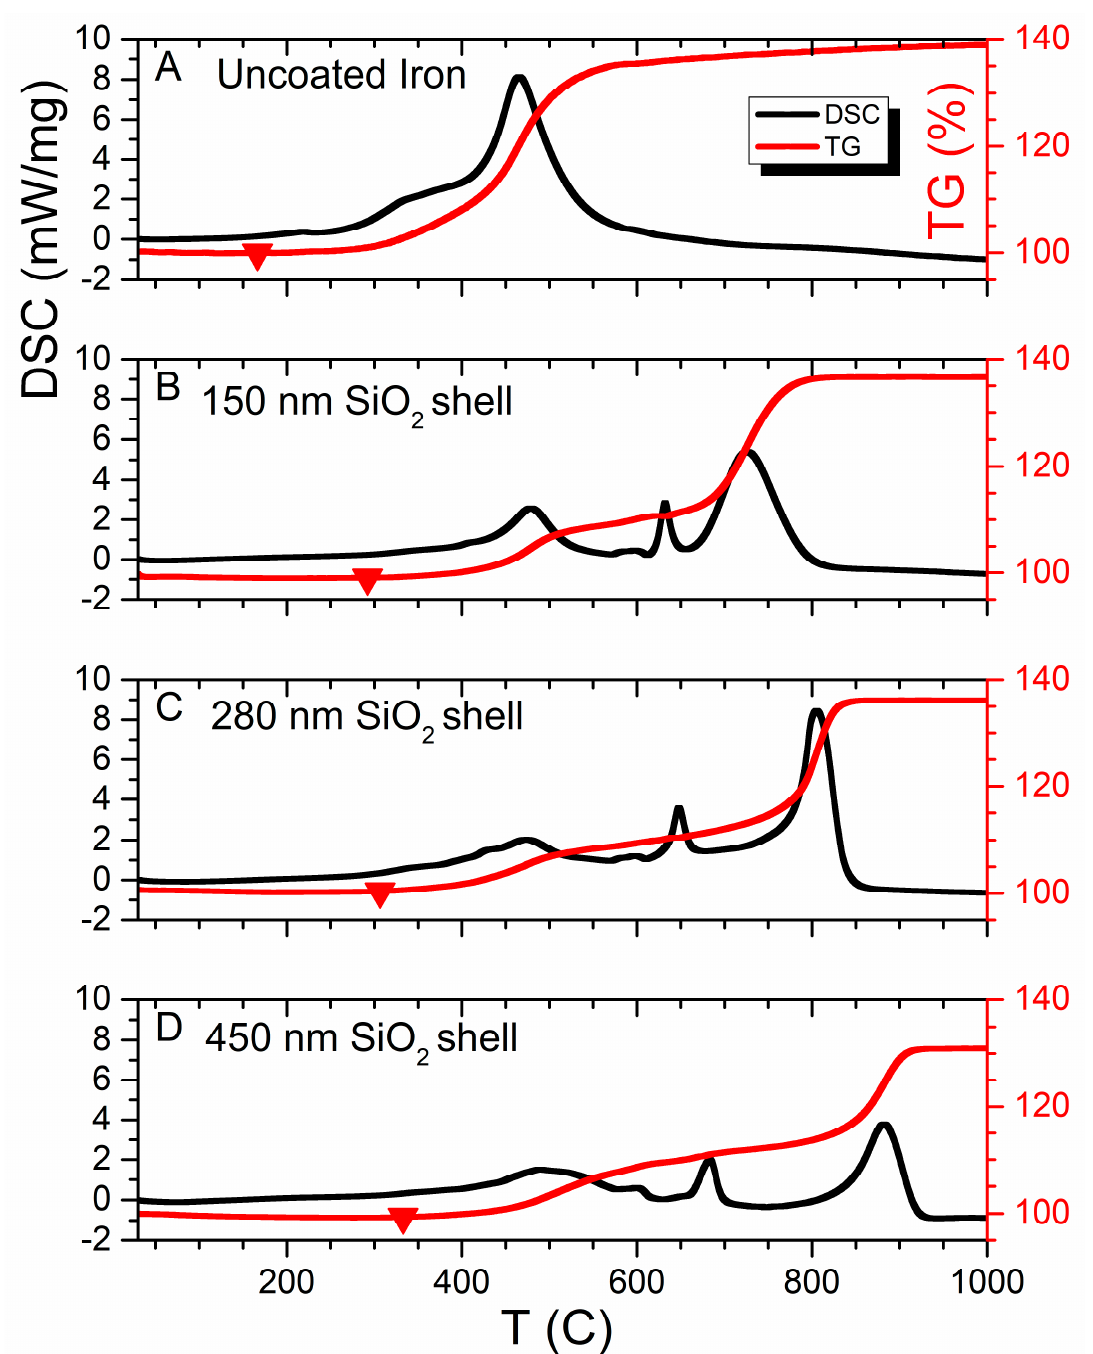
Figure 10. Synchronous thermal analysis results. Comparison of the curves for pure iron ( A ) and Fe-SiO 2 particles in cases of one, ( B ) two ( C ) and three ( D ) iterations.